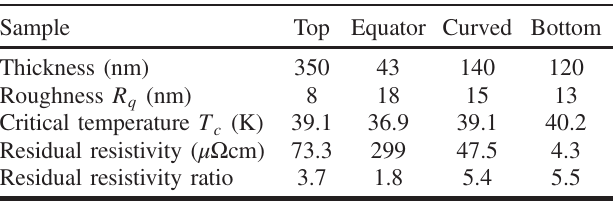
TABLE. II. The characteristics of the MgB 2 films deposited on the four samples mounted on the 6 GHz dummy